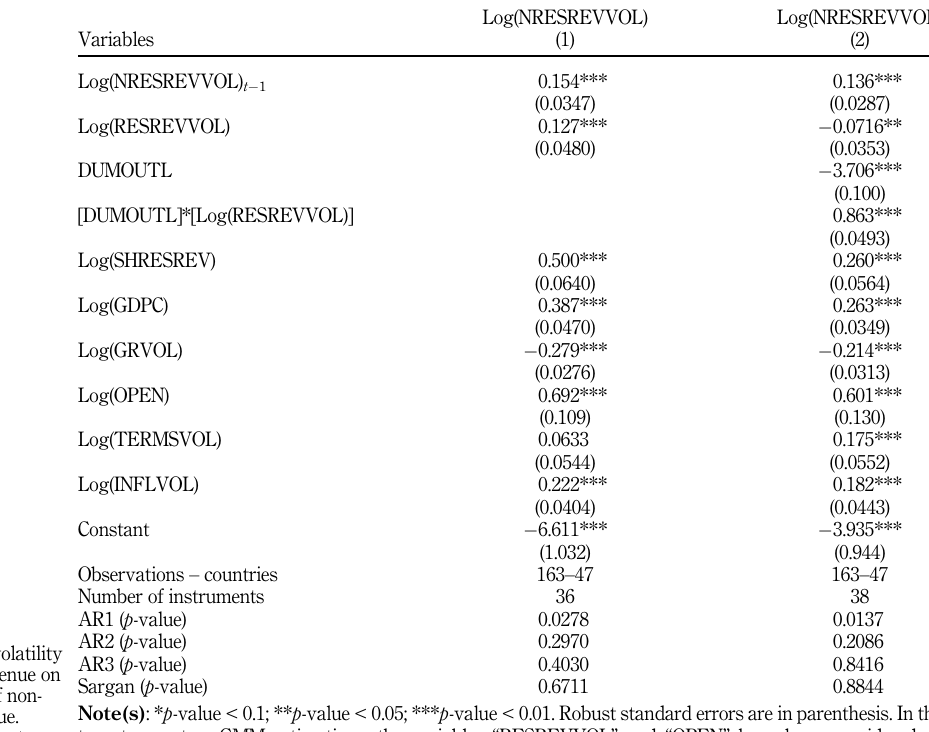
Table 2. Impact of the volatility of resource revenue on the volatility of non- resource revenue. Estimator : Two-step system